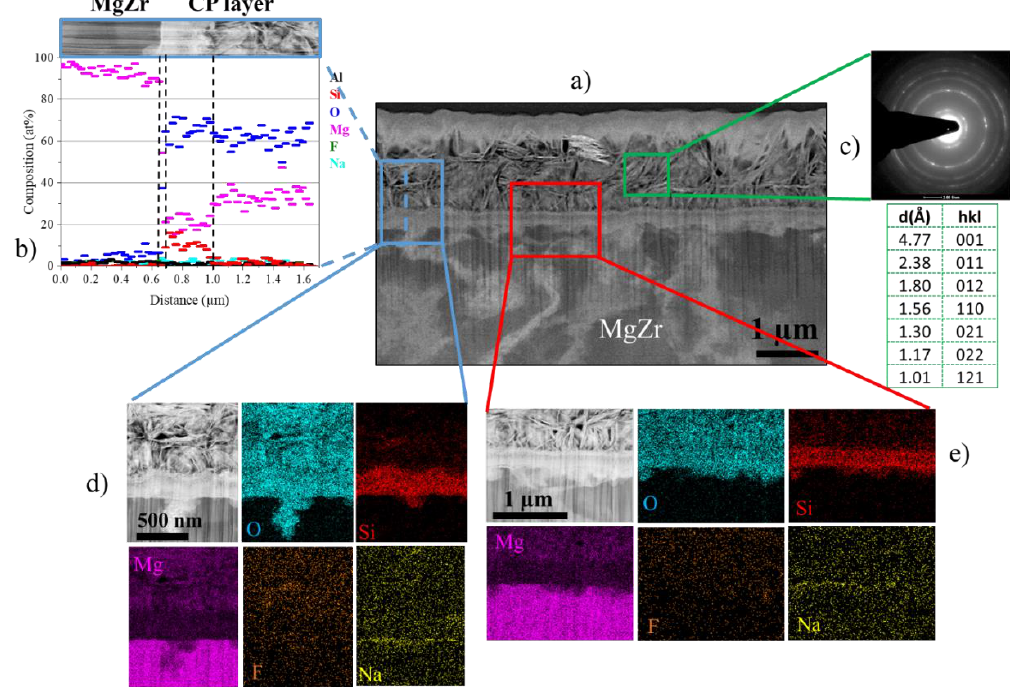
Figure 4. ( a ) Image of corrosion products (CP) layer of MgZr substrate corroded in PS during 360 days in DF-STEM mode, ( b ) elementary profile obtained in CP layer from EDX analysis (blue rectangle), ( c ) electron diffraction of the phase having platelet shape and identified as brucite Mg(OH) 2 (green rectangle), ( d , e ) EDX cartographies of two zones (red and blue rectangles).